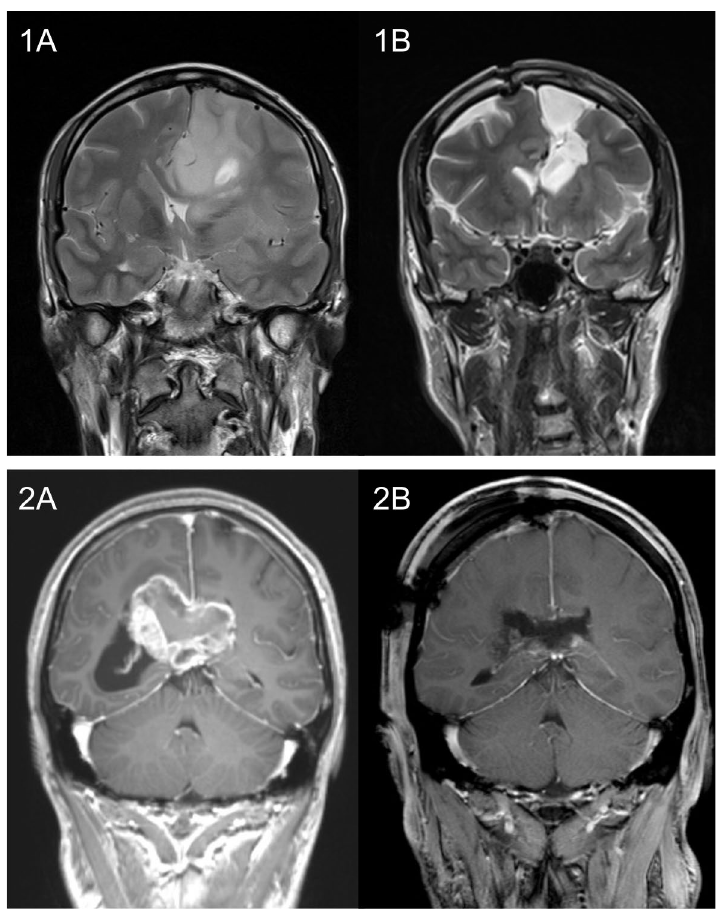
Figure 1. Examples of 2 patients with glioblastomas invading the corpus callosum. ( 1A) and ( 2A) depicting the tumor prior to surgery and ( 1B) and ( 2B) showing postoperative results. Patient 1, 36-years old, underwent STR of huge left frontal glioblastoma, followed by radiochemotherapy. He didn’t show any severe cognitive impairment at any time point (i.e. neither prior to surgery nor at long-term follow-up). Patient 2, 38-years old, underwent STR of huge glioblastoma involving the posterior body of the corpus callosum. Prior to surgery, he suffered from severe impairment of memory, improving gradually thereafter, as did postoperative new mild deficits in attention and language.